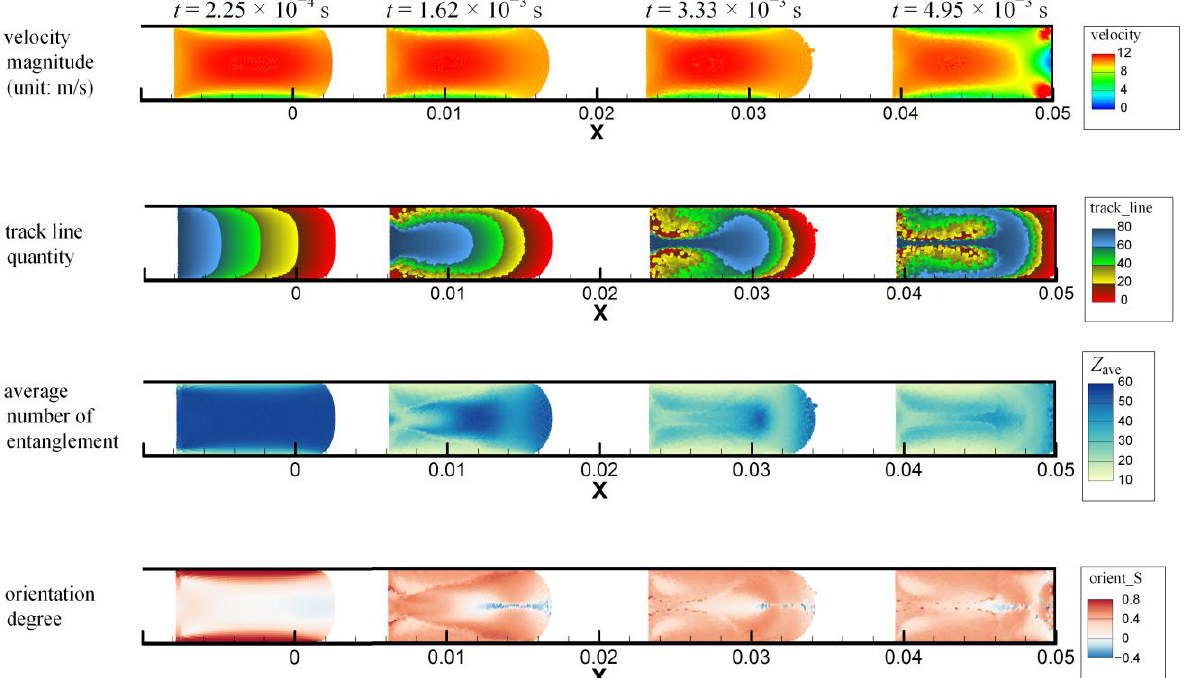
Figure 5. The sketch of the simple long rectangular cavity (unit: mm). The simulated velocity magnitude, track line quantity, average number of entan- glements Z ave and orientation degree S distributions of injection molding in the simple long rectangular cavity at times t = 2.25 × 10 − 4 s, 1.62 × 10 − 3 s, 3.33 × 10 − 3 s and 4.95 × 10 − 3 s are shown in Figure 6a-d, respectively. The animations corresponding to the above re- sults can be found in supplementary material Video S1 – S4. At the beginning of the injec- tion, Z ave and S near the cavity wall rapidly decrease and increase, respectively, which is similar to the previous Poiseuille flow example. During the injection process, the velocity distribution seems to remain stable in the polymer melt most of the time. The track line quantity of the rightmost column of melt particles at t = 0 s is defined as zero. Then the track line quantity of each column of particles is increased by one from right to left and remains constant for each particle during the simulation. As seen in the track line quan- tity result, melt tumbling occurs near the melt front (free surface) and the injection piston (moving boundary), and the micro Z ave and S results are also affected. Z ave and S in the center area of the melt changes little at the beginning of the injection. As the melt near the cavity wall gradually tumbles to the center area, it experiences shearing near the cavity wall and the piston. Hence the melt with lower Z ave and higher S gradually occupies the center area.